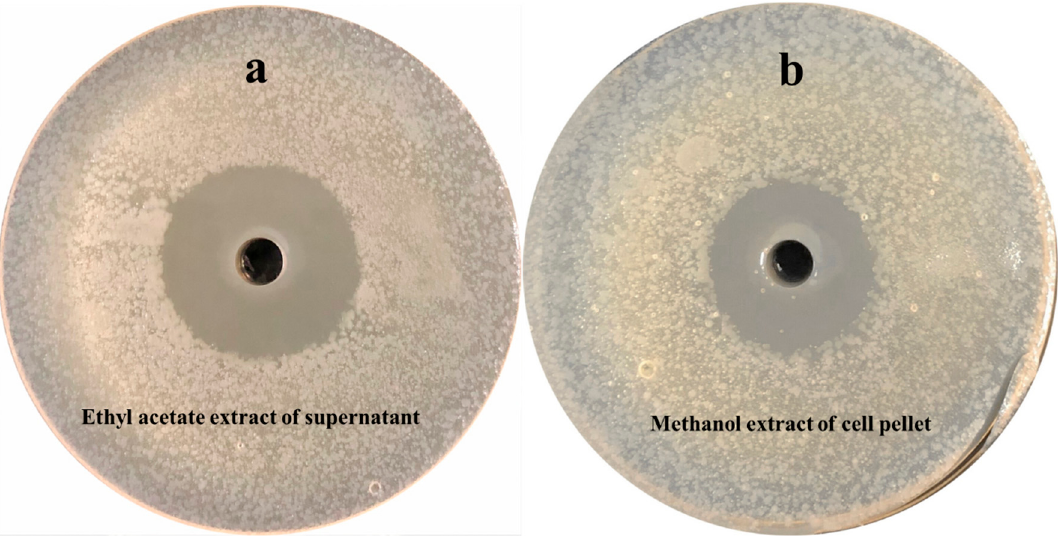
Figure 5. The antibacterial activity of the extract of the supernatant ( a ) and cell pellet of strain NEAU-SSA 1 T ( b ) against Ralstonia solanacearum .